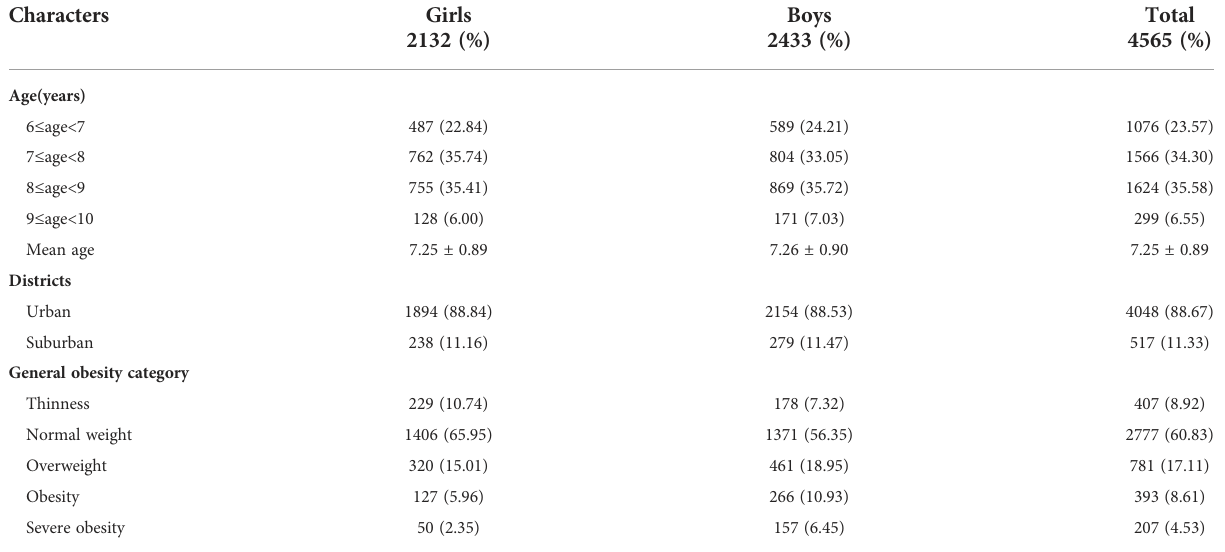
TABLE 1 Basic characteristics of the subjects.